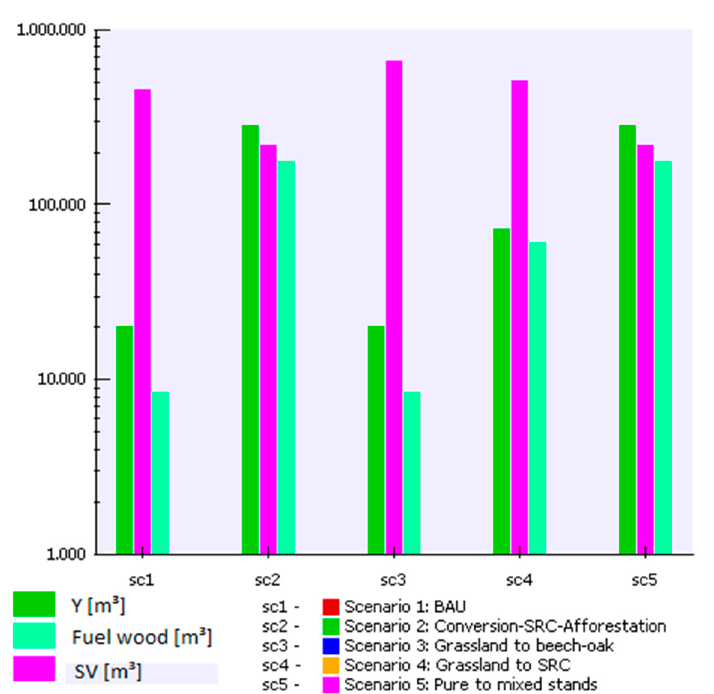
Figure 7. Five scenarios for the focus area Müglitz valley at the time step zero. Yield (Y), standing volume (SV), and the assortment of fuel wood are illustrated. The colors of the scenarios correspond to Figure 10.